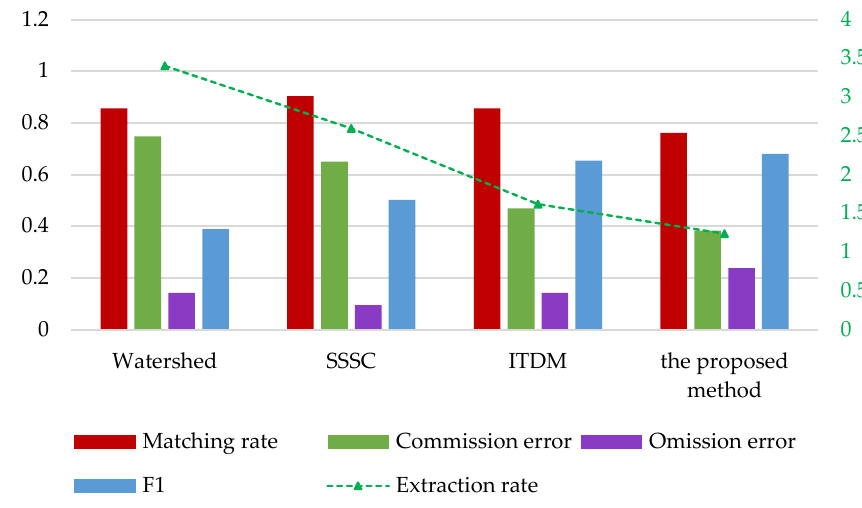
Figure 15. Accuracy comparison among four different methods in Sample 4.